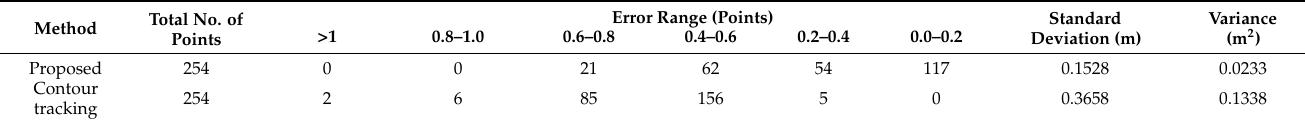
Figure 16. ( a ) The superposition of point cloud of the two methods, and point cloud of cliff segment; ( b ) The superposition of coastline of the two methods, and point cloud of cliff segment. According to error theory, when the true value is unknown and there are multiple groups of observations, the average value of each group of observations can be regarded Table 1. The error and accuracy data of the two as its approximate true value. Therefore, assuming that the coastlines generated by the